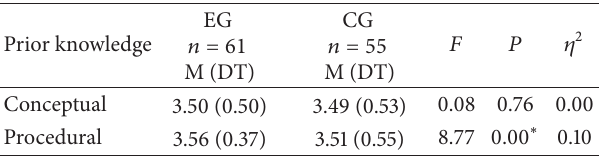
Table4:SinglefactorANOVAofpriorknowledgeaftertheprogram (experimental versus control